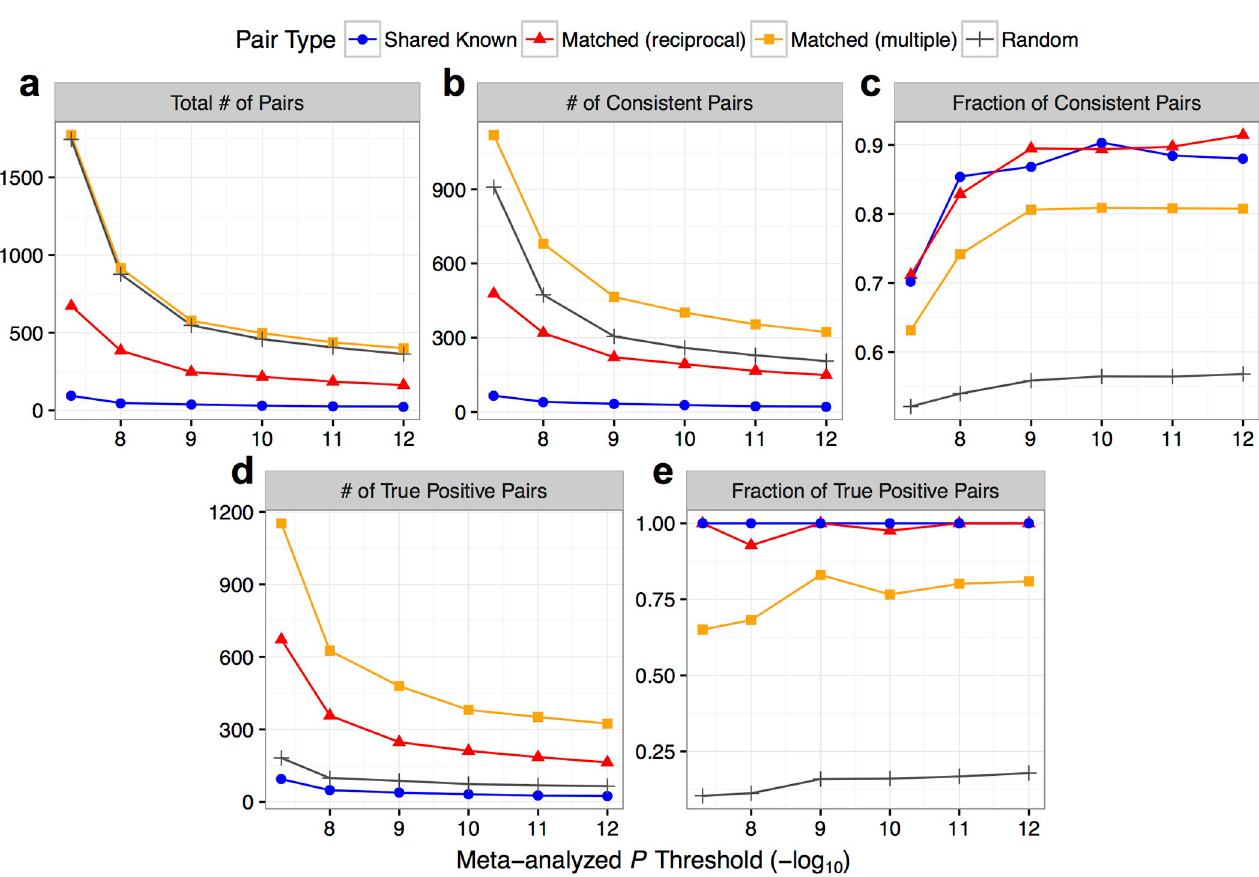
Fig 2. Genetic validation of OE-MCDS matched signals. GWAS were performed for “multiple” matched signal pairs (a subset of which were “reciprocal”), shared known pairs (“Shared Known”, positive control), and randomly matched pairs (average statistics shown as “Random”, negative control) in OE and MCDS, followed by meta-analysis that ignored direction of effect. For each pair, the SNP with the best meta-analyzed p -value was selected to assess directional consistency of its association in the two cohorts. (a) “Total # of Pairs”: number of signal pairs with best SNPs below p -value threshold; (b) “# of Consistent Pairs” and (c) “Fraction of Consistent Pairs”: number and fraction of pairs with directionally consistent best SNPs below p -value threshold; (d) “# of True Positive Pairs” and (e) “Fraction of True Positive Pairs”: number and fraction of true positive pairs were estimated as described in Methods. X-axes start at genome-wide significant p -value threshold ( p < 5 × 10 − 8 ). Error bars for “Random” pairs were excluded due to low visibility (all close to